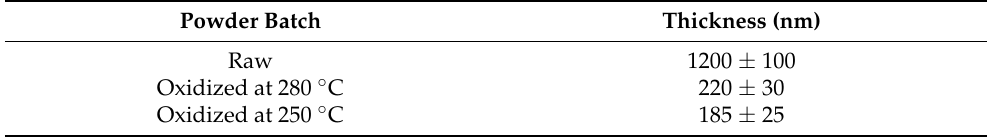
Table 1. Thickness of the oxide layer for each powder